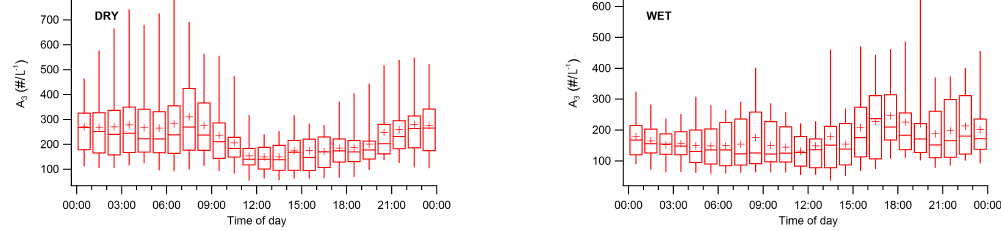
Figure 3. The average diurnal variation of cluster A 3 (non-fluorescent particles) during dry (top) and wet (bottom) periods. Whiskers represent the 5th and 95th percentiles; the boxes, inter quartile ranges. The central line represents the median, and the mean is shown by the cross symbol.